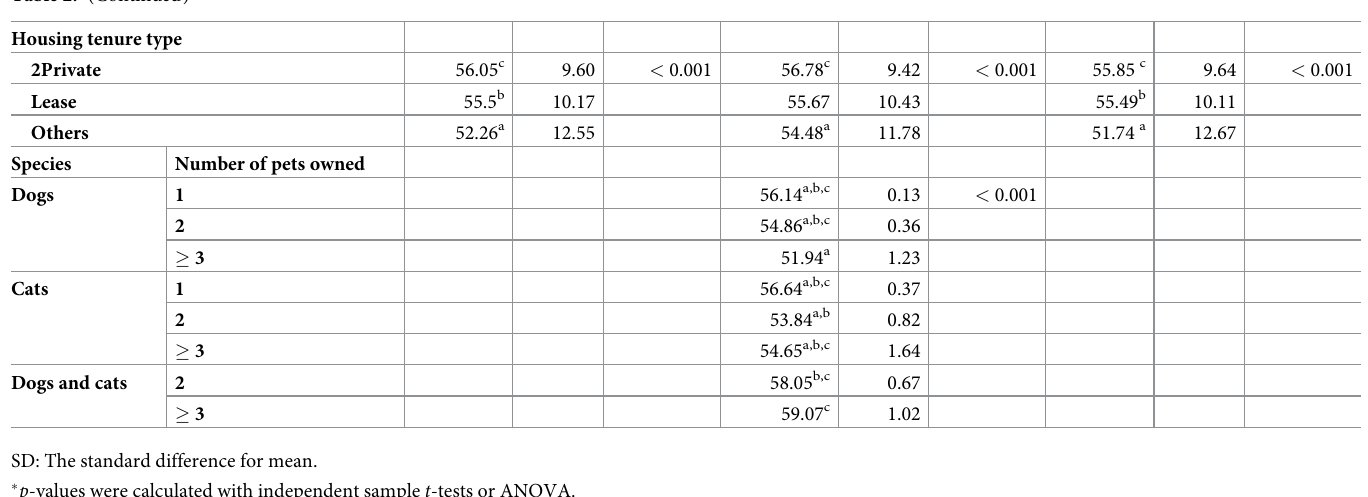
Table 4 presents the results of survey-weighted multiple linear regression analysis among the owners’ group, as stratified by the number of pets owned. The overall life satisfaction level among owners with only one pet was 1.455 points higher (95% CI = -2.288 –-0.628) than those with two pets, and 2.279 points higher than those with three or more pets (95% CI = -3.940 –-0.618) under controlled conditions. Thus, overall life satisfaction decreased as the number of pets increased when pet types were adjusted